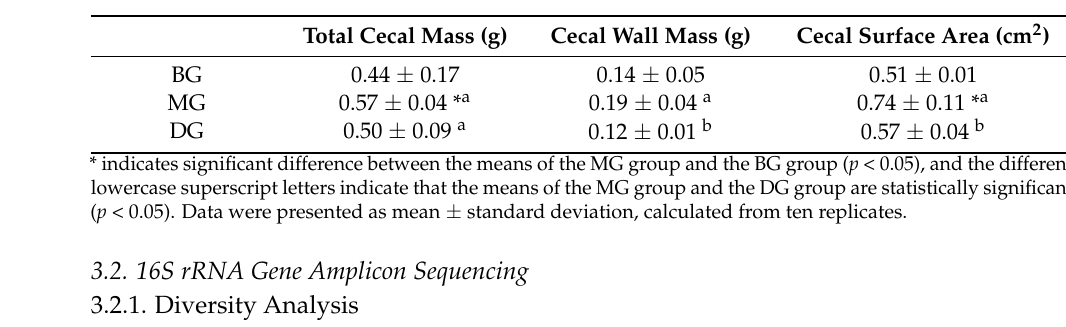
Table 2. Effect of hydroxy-alpha-sanshool on cecum index in